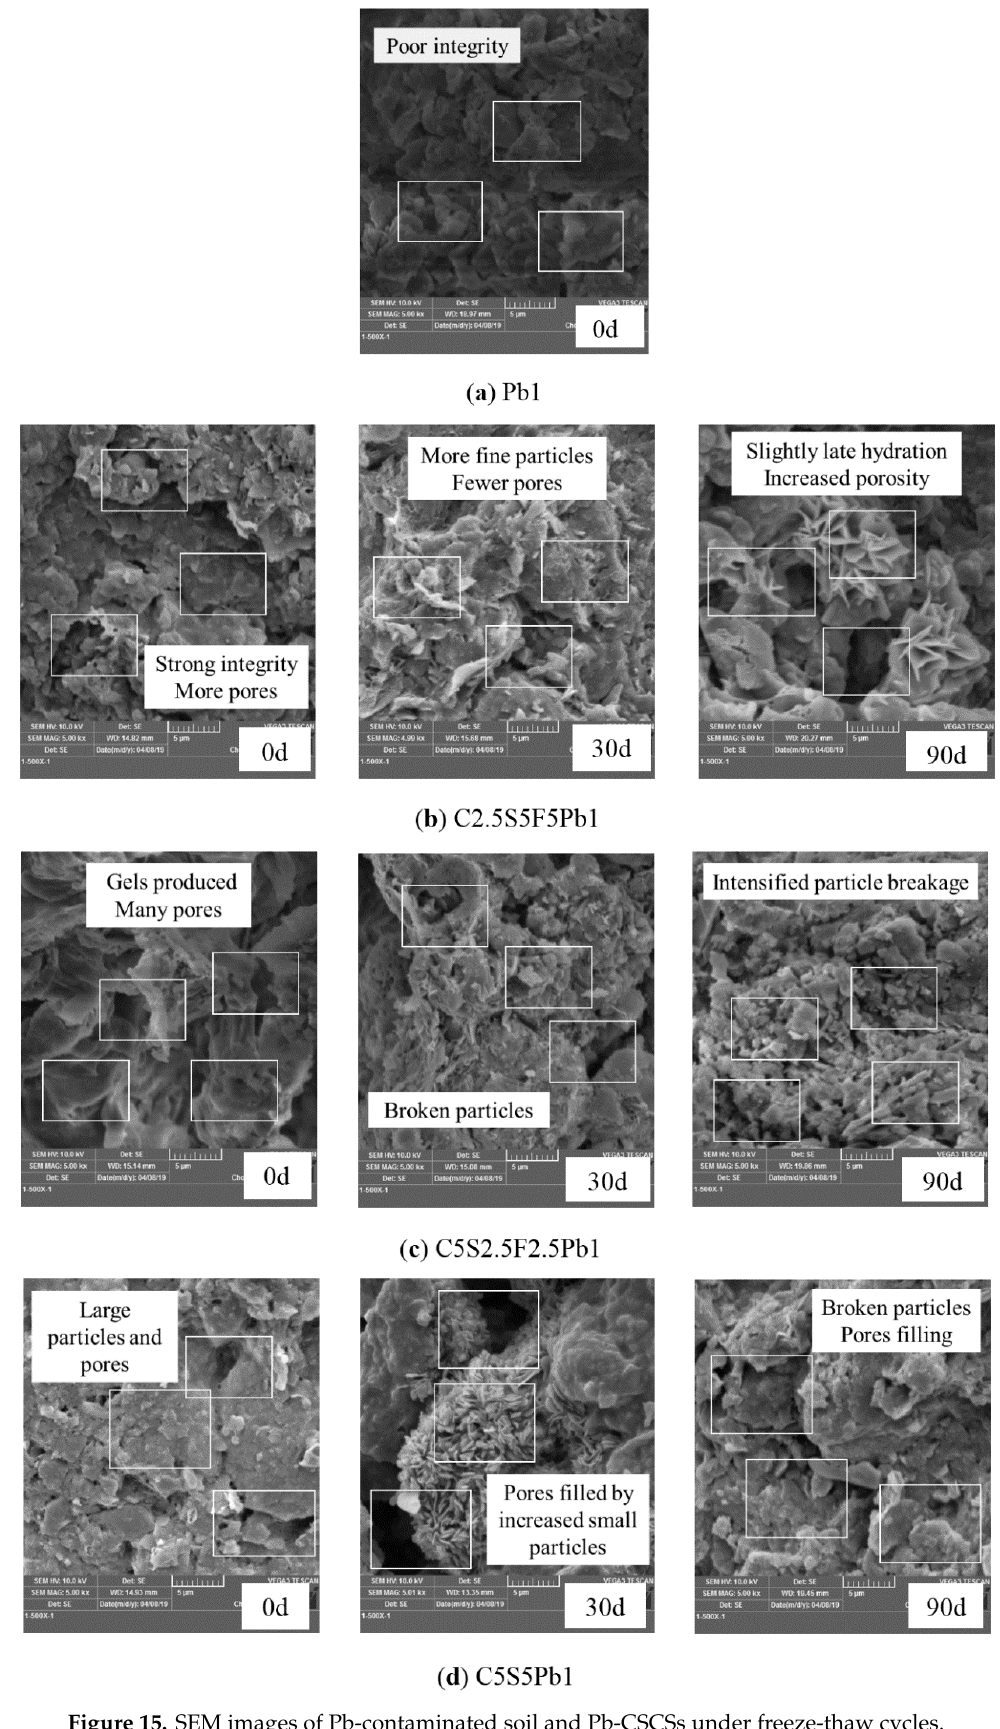
Figure 15. SEM images of Pb-contaminated soil and Pb-CSCSs under freeze-thaw cycles.